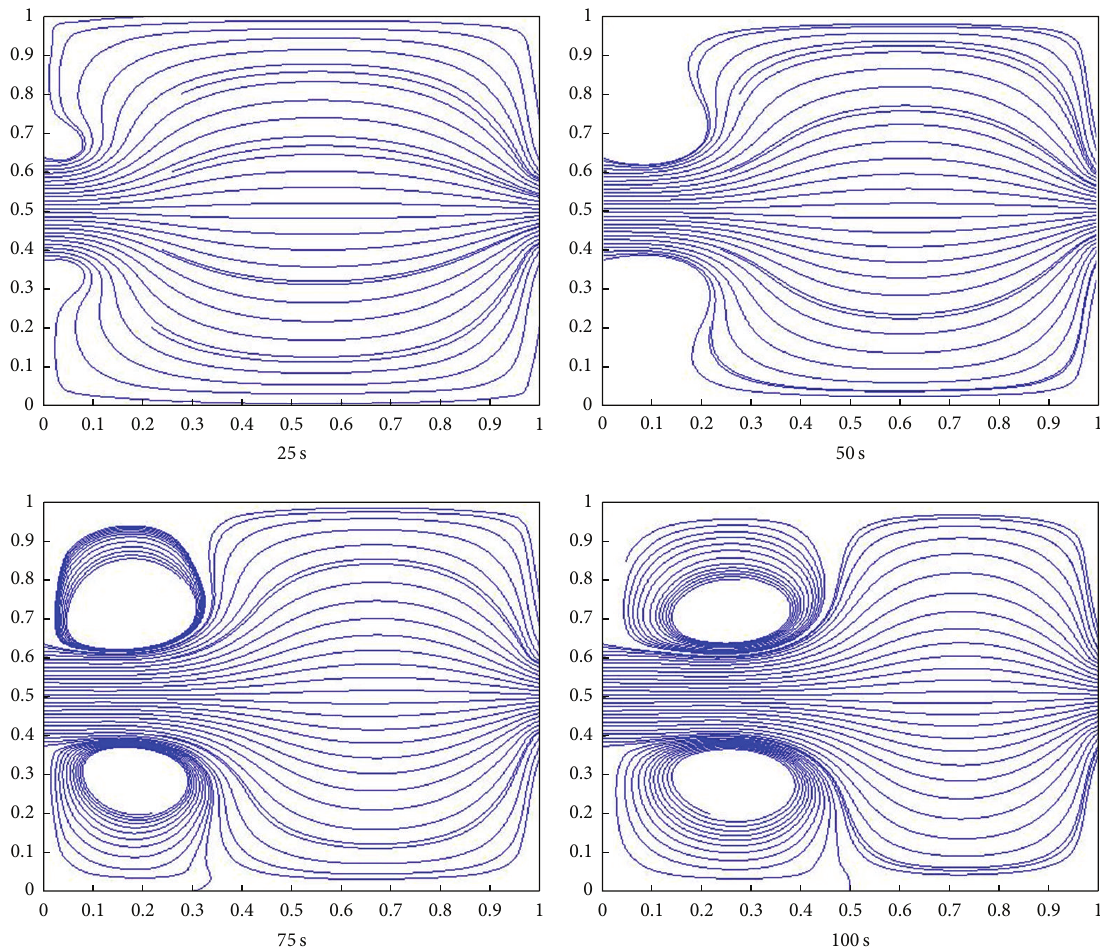
Figure 5: Velocity vector streamline diagram of the free-flow region at different times.